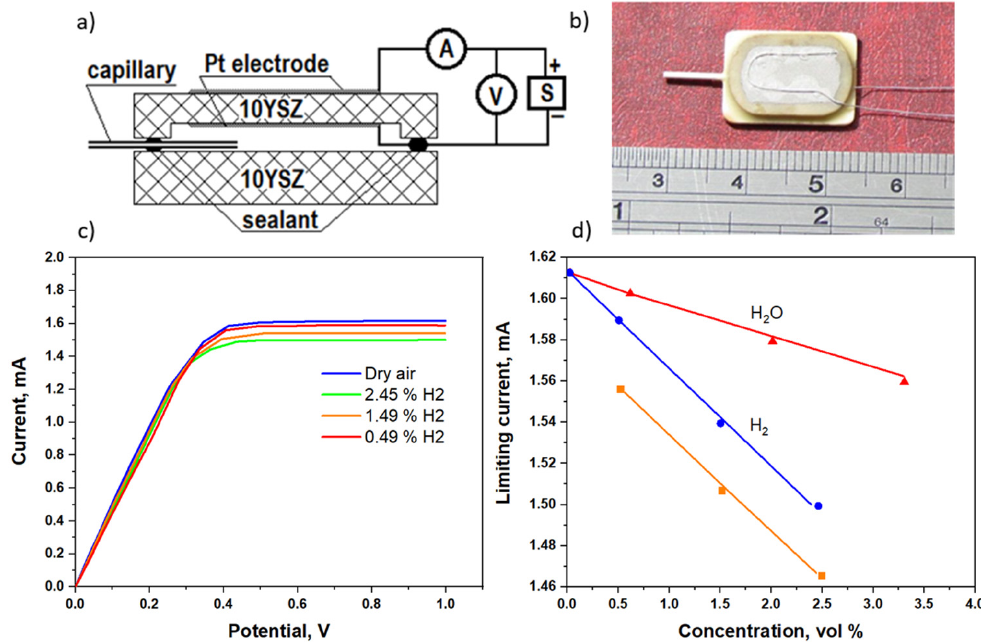
Figure 7. ( a ) The configuration of the amperometric sensor for the detection of hydrogen and steam in atmospheric air; ( b ) a photograph of the manufactured sensor along with a ruler for the estimation of its dimensions; ( c ) V-I curves of the amperometric sensor for the H 2 + dry air mixture plotted at different hydrogen concentrations; and ( d ) the limiting current plotted against the hydrogen concentration (triangles) in dry air, steam concentration (circles) in air and the hydrogen concentration in the humidified mixture (3.3%) of H 2 + air. (Data reproduced from